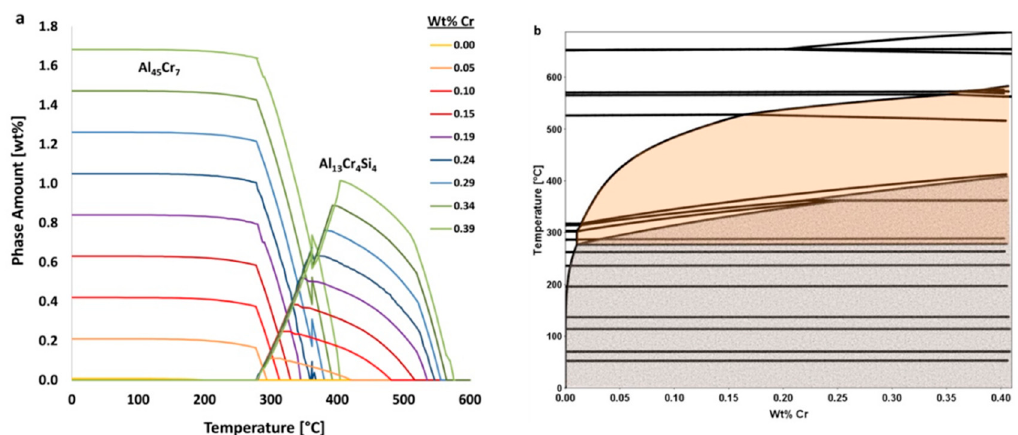
Figure 18. ( a ) The resulting phase fractions of Al 13 Cr 4 Si 4 and Al 45 Cr 7 as a function of chromium content. ( b ) The isopleth of Al 6061 with varying chromium contents. The orange shaded region in ( b ) represents the presence of Al 13 Cr 4 Si 4 , whereas the grey shaded region in ( b ) represents Al 45 Cr 7 .